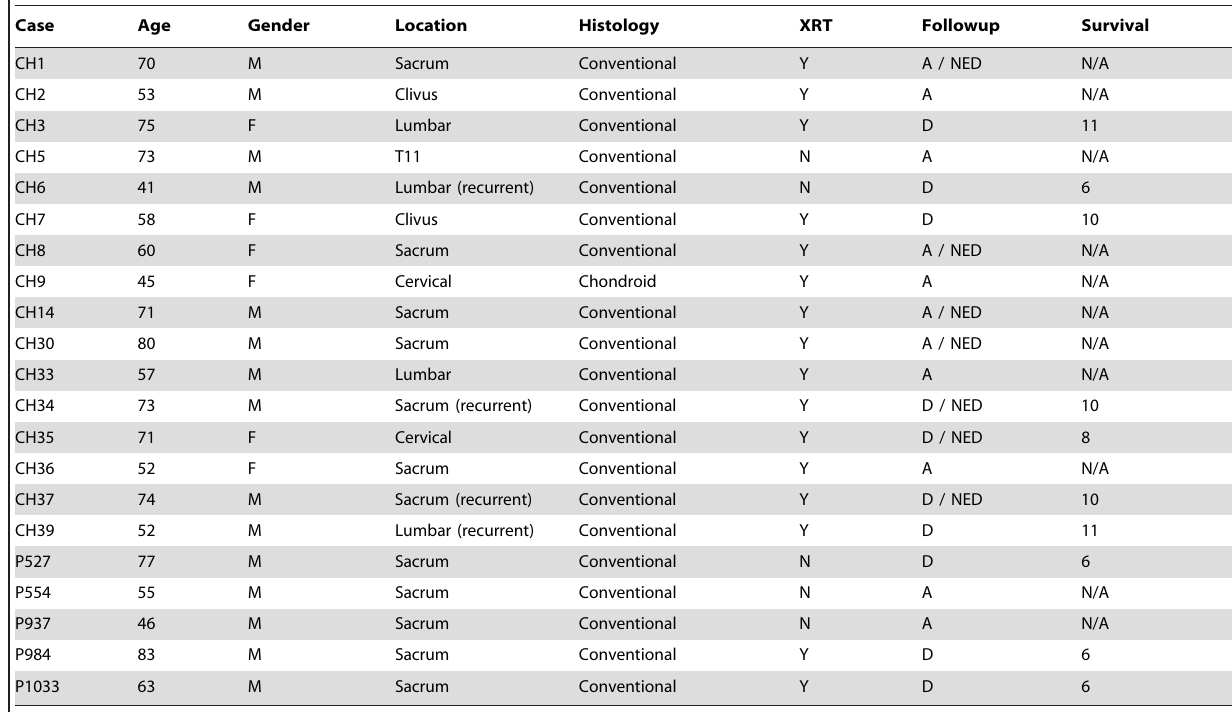
Table 1. Clinical information.